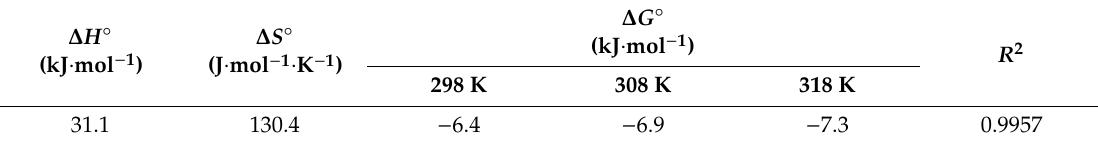
Table 4. Thermodynamic parameters for adsorption of cadmium (II) on the functionalized